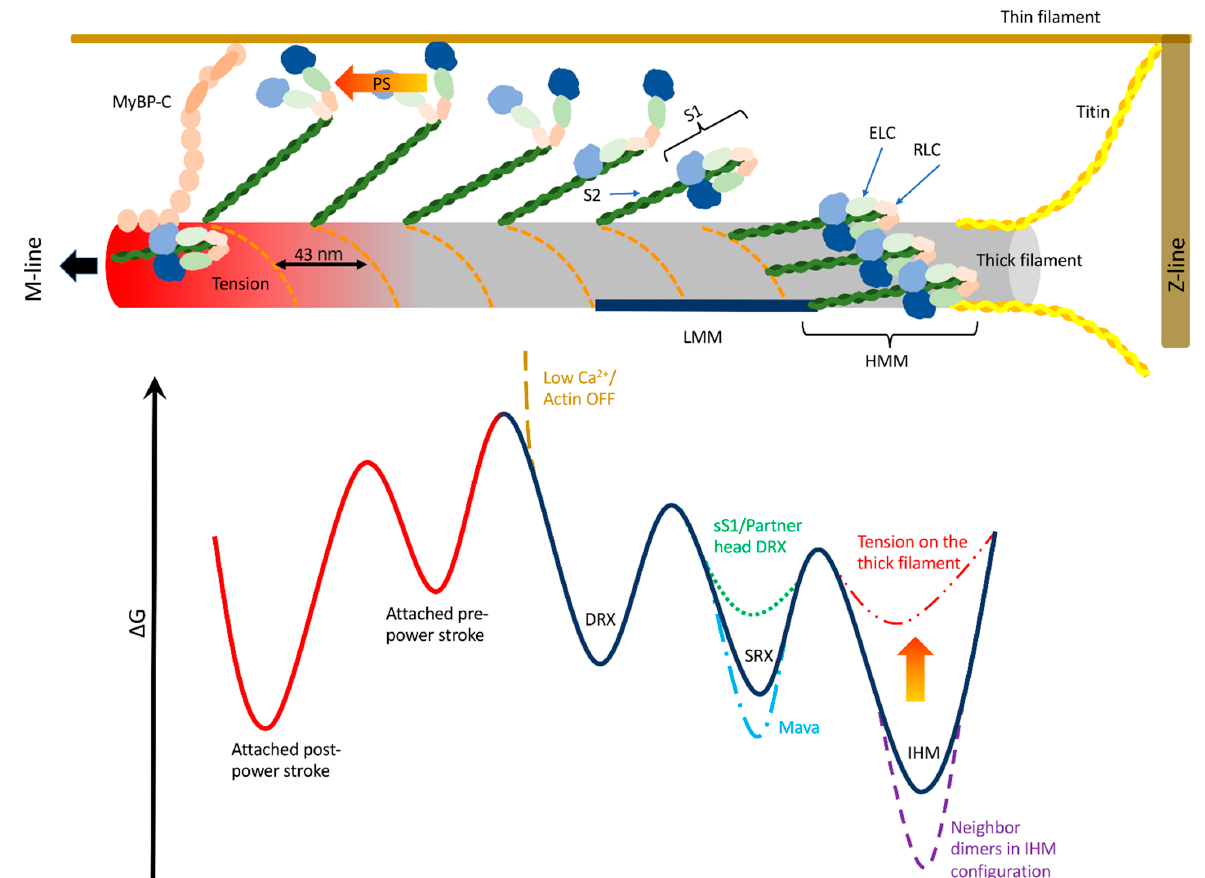
Figure 1. Schematic drawing of the myosin domains, of the thick filament activation ( upper part) and of the myosin stable states energies ( lower part). From top to bottom and from right to left: Thin filament, whose regulatory proteins are not shown, is activated by Ca 2+ ions and is attached to the Z-line. Myosin LMM domains form the thick filament, attached to the Z-line via titin, while contiguous HMMs form the interacting head motif (IHM), stabilized by intra-molecular interactions, and helically folded motors, stabilized by inter-molecular interactions. Titin runs from Z-line to the M-line along the thick filament, not depicted for clarity. MyBP-C runs from thick filament, stabilizing its OFF state, to thin filament, sensitizing it to Ca 2+ . The single sS1 is formed by the motor domain the RLC and the ELC, and can either be in an autoinhibited super-relaxed state (SRX) or in a disordered relaxed state (DRX), pointing toward the actin filament and ready to create the actomyosin complex and generate force through the power stroke (PS). Tension (red) is transmitted along the thick filament from the attached motor toward the M-line. The bidimensional simplification of the energetic landscape of the myosin stable states (lower part of the figure) depicts the possible effects described in the text. The tension (red) destabilizes the helically ordered IHMs which are instead stabilized by the inter-molecular interactions through the neighbor dimers (purple). The autoinhibited state of the sS1 is stabilized by mavacamten (light blue) and destabilized by the loss of the intra-molecular interactions (green). When actin is non activated, at low calcium, the actomyosin formation is prevented (light brown energy